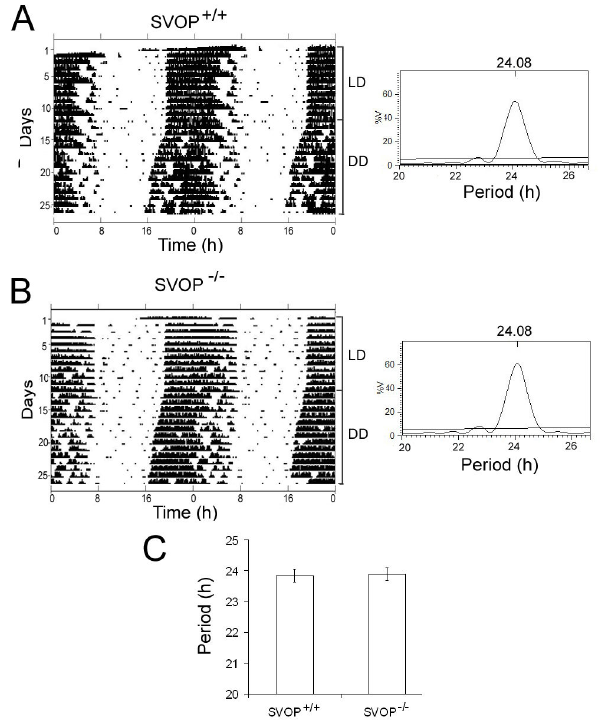
Figure 7. Circadian activity is normal in SVOP knockout mice. A , B ) Shown are representative actograms and periodograms of wheel-running activity in wild-type ( A ) and SVOP knockout ( B ) mice under a 12 h : 12 h light/dark cycle and 12h: 12h dark/dark cycle. Left panels show representative actograms of two days’ activity plotted twice to demonstrate the circadian pattern. Right panels are periodograms that show the percent of behavioral variance (% V) accounted for by a circadian rhythm of x hours long. C ) Calculated circadian period in constant darkness (DD) was similar for wild-type (+/+) and SVOP knockout (-/-) mice. The plot shows the mean ± SEM of the values calculated by periodogram analysis (two- tailed Student t test, P = 0.85, n = 6 for each